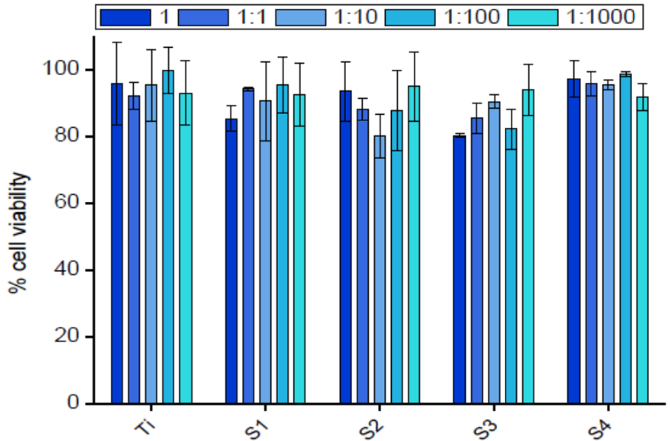
Figure 10. Cell viability of hFFs on the different surfaces, with respect to the control (Ti) in the indirect cytotoxicity test. No statistically significant differences between the conditions were found.